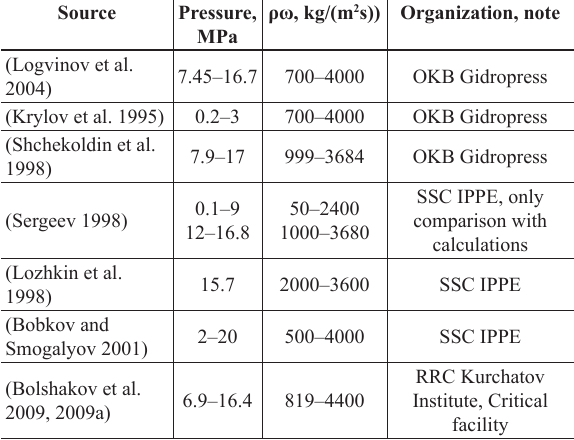
Table 1. Parameters for studying critical heat flux